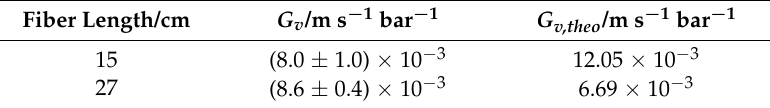
Table 3. Theoretical and measured pressure-dependent gas velocities.